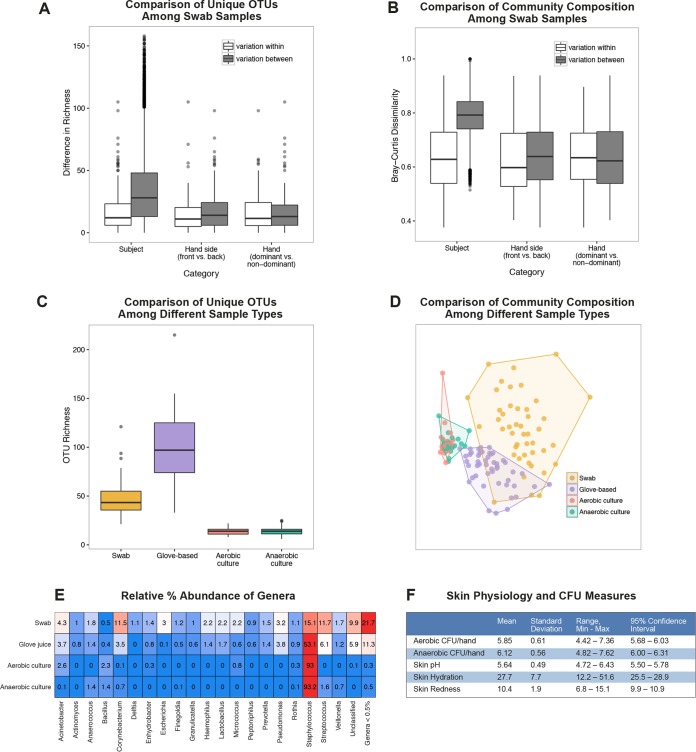
Characterization of the skin and microbiota of hands at baseline. (A and B) OTU richness (A) and Bray-Curtis dissimilarity (B) in bacterial community composition in samples from swabs collected immediately before hygiene treatment between samples across subjects versus within subjects, between samples from different sides of hands versus between samples from the same side of hands within subjects, and between samples from different hands versus between samples from the same hand within subjects. Boxplots represent minimum values, first quartiles, medians, third quartiles, maximum values, and outliers. (C and D) Diversity measured as richness of bacterial OTUs (C) and diversity (D) illustrated using nonmetric multidimensional scaling (NMDS) ordination showing differences in bacterial community structure observed from swabs, glove-based samples, and anaerobic culture plating of glove-based samples and aerobic culture plating of glove-based samples. (E) Relative percent abundance of genera recovered at baseline by swab, glove-based, aerobic plating, and anaerobic plating. Blue represents lower relative abundances, and red represents higher relative abundances. (F) Baseline results for aerobic and anaerobic bacterial CFU levels and skin pH, hydration, and redness measures. Min, minimum; Max, maximum. n = 50 for all measures.